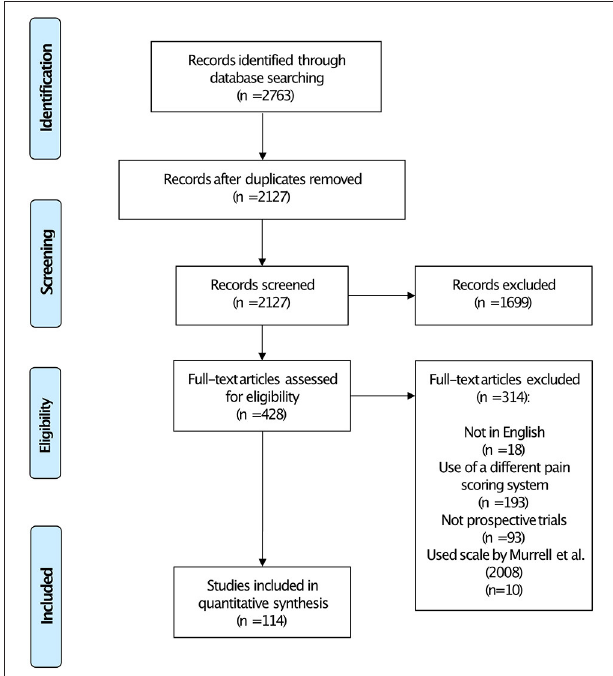
FIGURE 1 | Preferred Reporting Items for Systematic Reviews and Meta-Analyses (PRISMA) flowchart showing the number of studies included in each stage of the review.